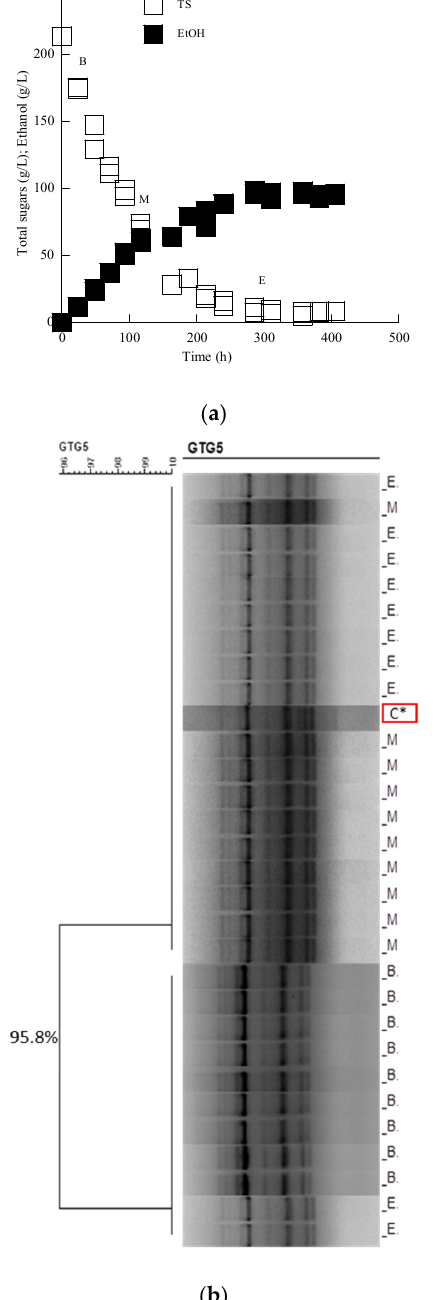
Figure 6. ( a ) Sugar and ethanol evolution of S. cerevisiae Passion Fruit in must from the grape variety Mavrotragano. Each experimental point is the mean value of 2 independent measurements (SE for most experimental points ≤ 17%). ( b ) Dendrogram generated after cluster analysis of the digitized (GTG)5-PCR fingerprints of the 31 isolates from the beginning (B), middle (M) and end (E) of the fermentation kinetics in the grape must media. The control condition (C*) is the relative rep-PCR profile of the pure culture of the S. cerevisiae Passion Fruit strain. The dendrogram was constructed using the unweighted pair-group method using arithmetic averages with correlation levels expressed as percentage values of the Pearson correlation